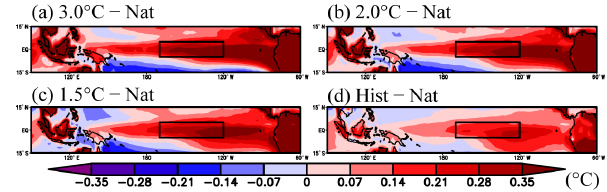
Figure 4. Surface air temperature warming patterns in 2015. (a) (cid:49)T differences between 3.0 ◦ C and Nat ( ◦ C). The 30 ◦ S–30 ◦ N ocean averaged value is subtracted. The black box indicates the Niño 3.4 region. The other panels are the same as panel (a) but for (b) 2.0 ◦ C and Nat, (c) 1.5 ◦ C and Nat and (d) Hist and Nat. first to report results from the HAPPI extension (i.e. the 3 ◦ C runs) using MIROC5.